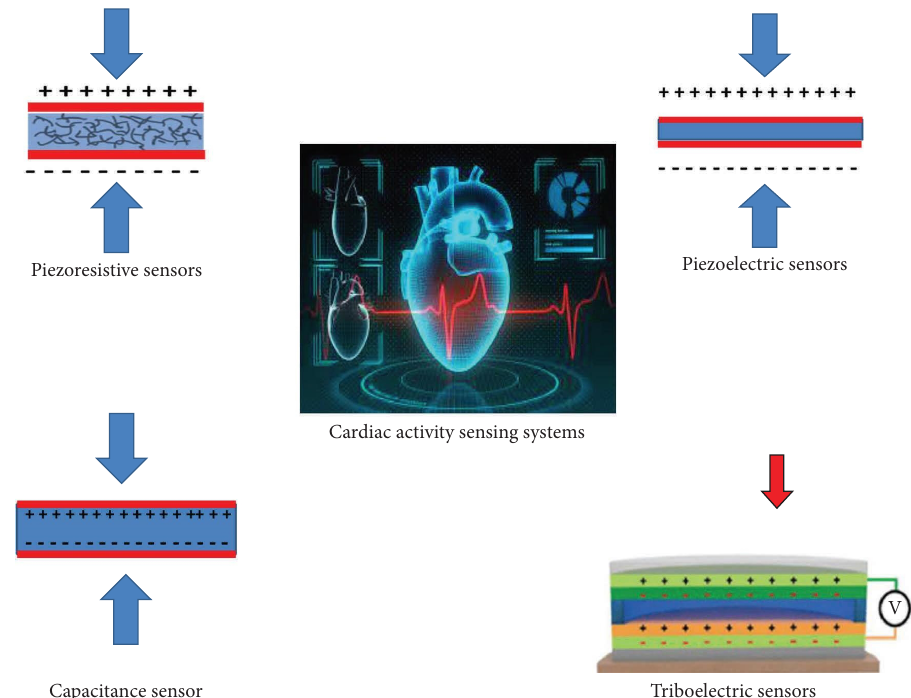
Figure 2: Schematic illustration of diferent sensing systems for cardiovascular